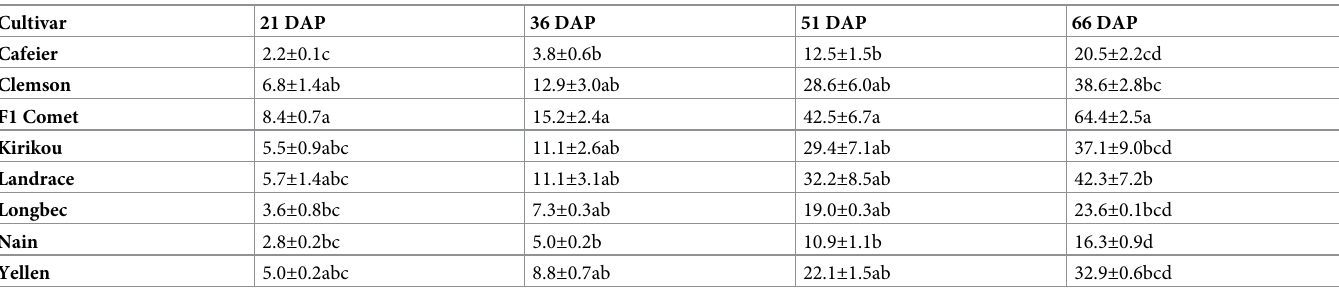
Table 6. Plant height of okra cultivar.